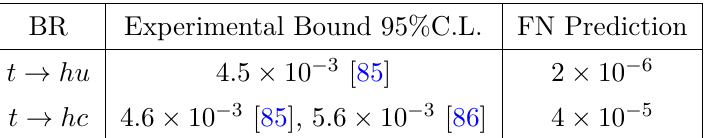
The numerical results for the corresponding branching ratios, considering the total decay width Γ = 1 . 42 +19 GeV [30], can be read in table 13: the FN predictions are below t − 15